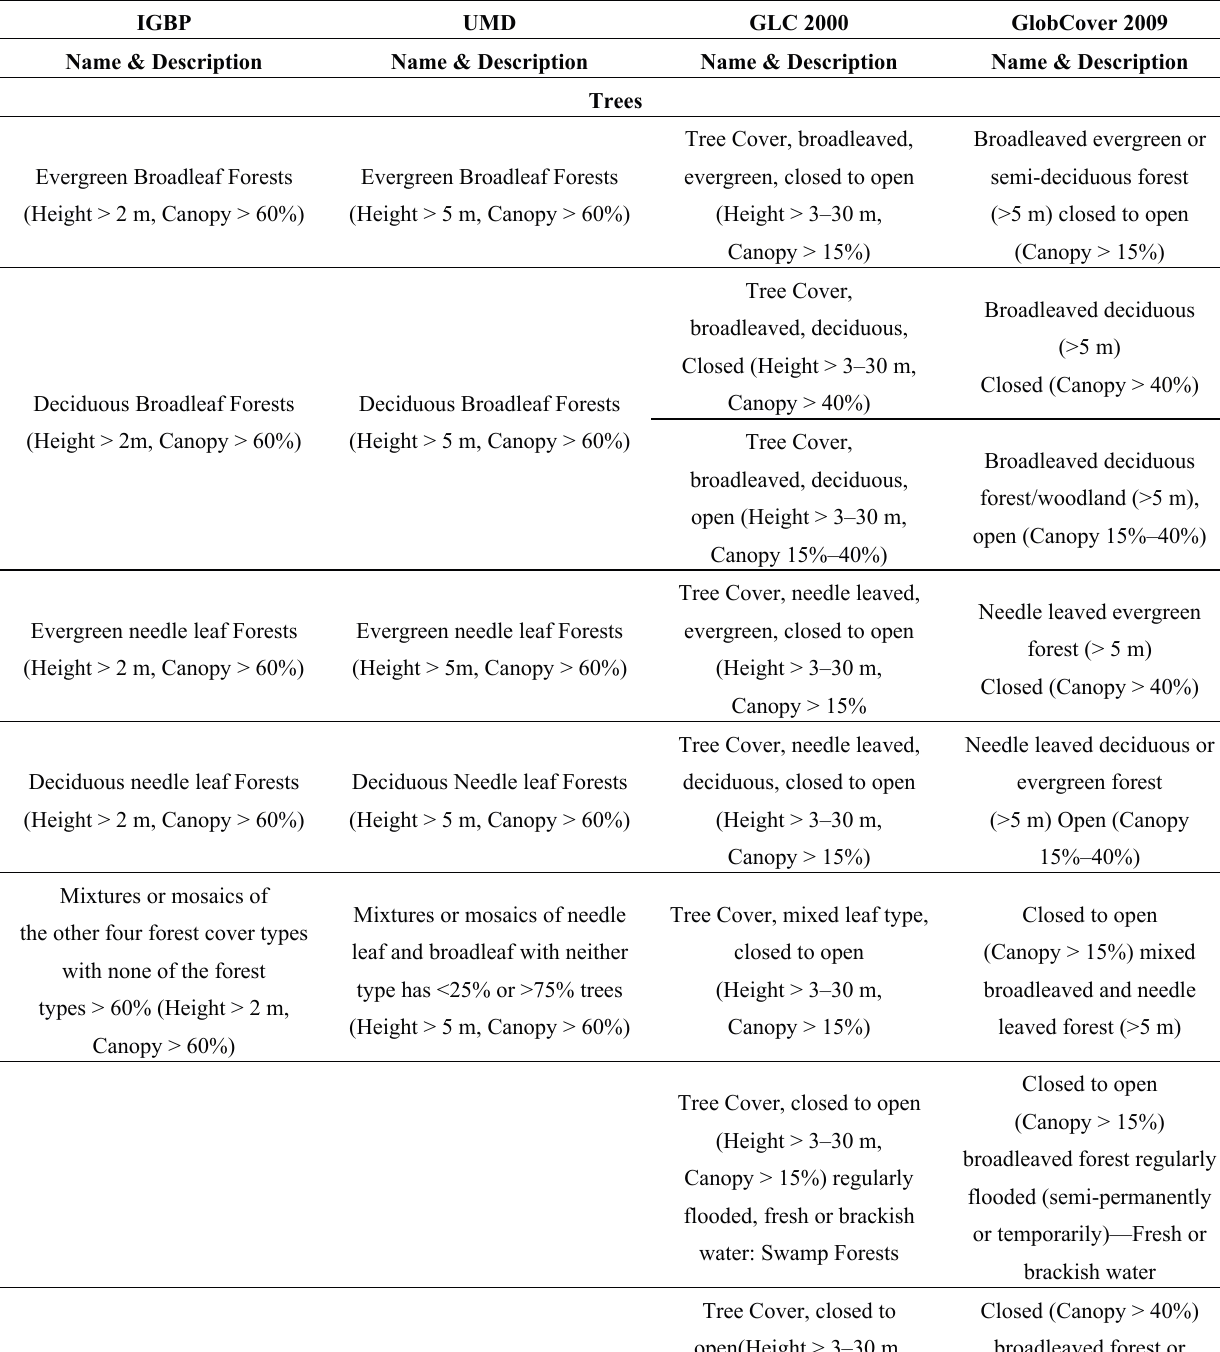
Table 4. Four global land cover legends with definitions for just the forest/trees and cropland